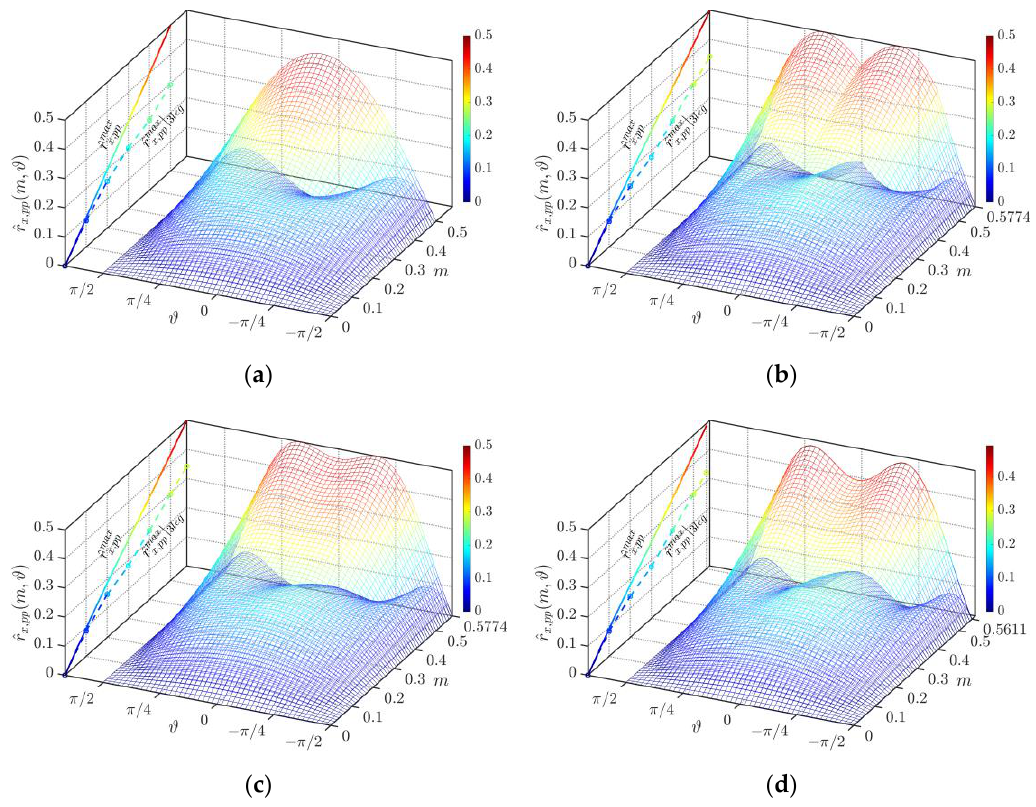
Figure 16. Normalized primary and secondary peak-to-peak phase current ripples in case of: ( a ) SPWM; ( b ) CPWM; ( c ) THIPWM1/6; and ( d ) THIPWM1/4.